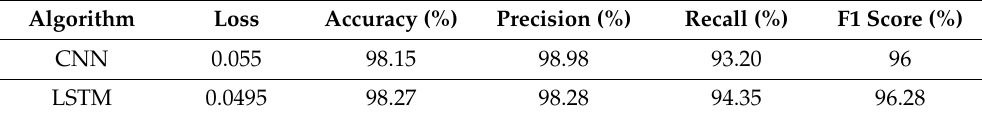
Table 8. Results of deep learning using binary